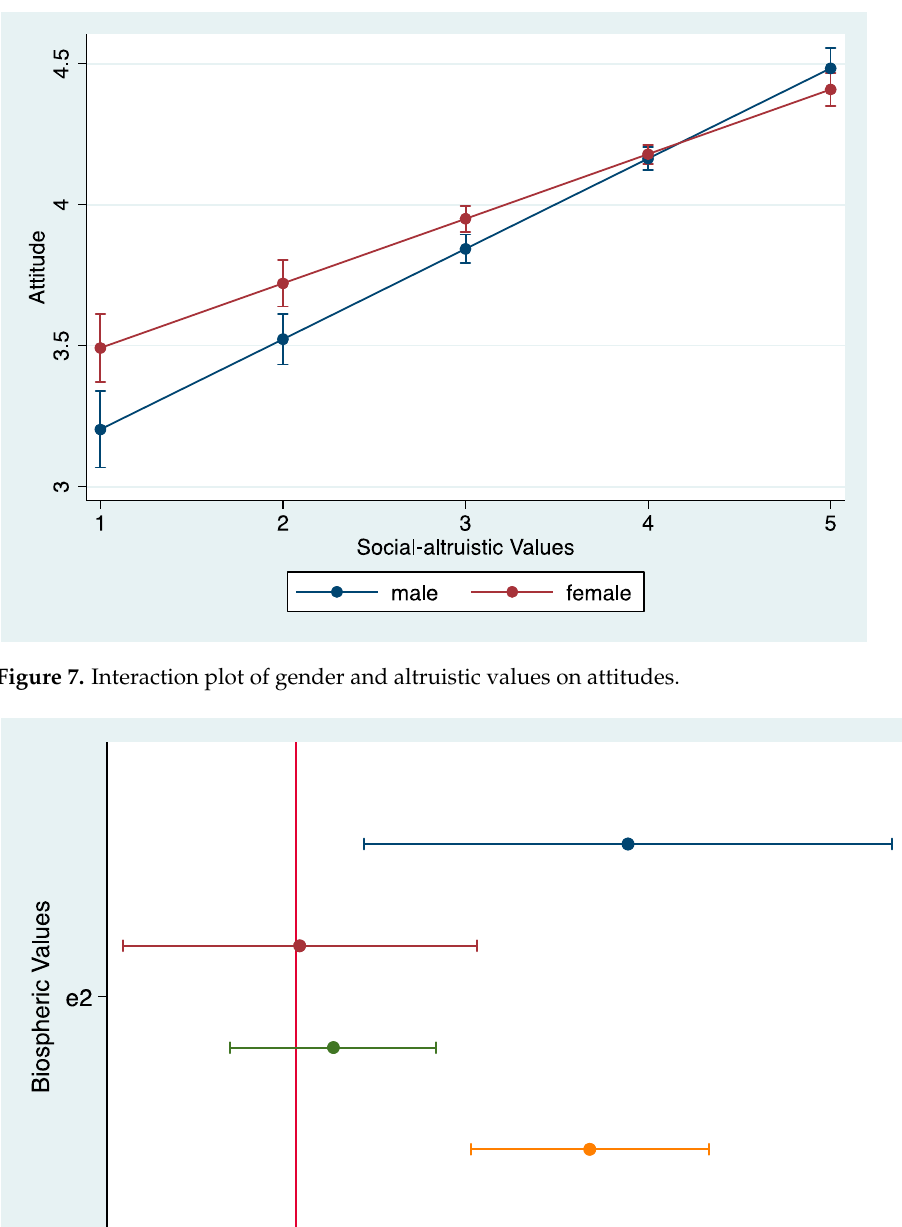
Table 11. Heterogeneous effect of income in the relationship of biospheric values and attitudes.